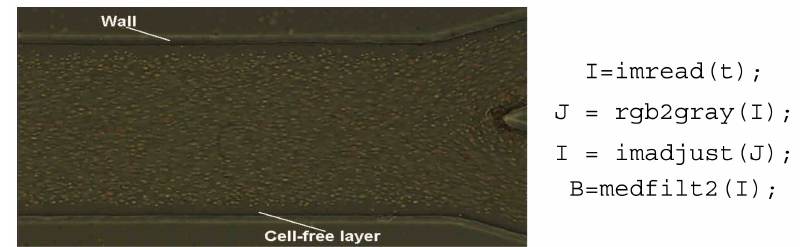
Figure 14. An image from the original sequence of images. Then, the intensity of each pixel in the frame sequence was evaluated to obtain an image with the maximum intensity. With this step, it was possible to identify the region with the highest concentration of blood cells and the region where blood cells do not exist, the cell-free layer (CFL). The regions that represent the CFL have the highest intensity (white) near the microchannel walls (cf. Figure 15).